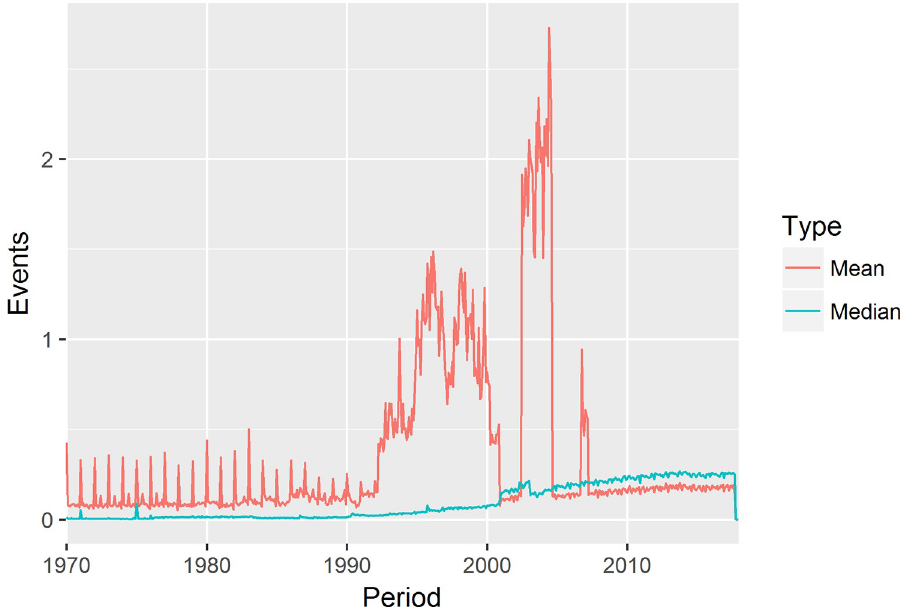
Fig 2. Monthly event recording rates: Mean vs.